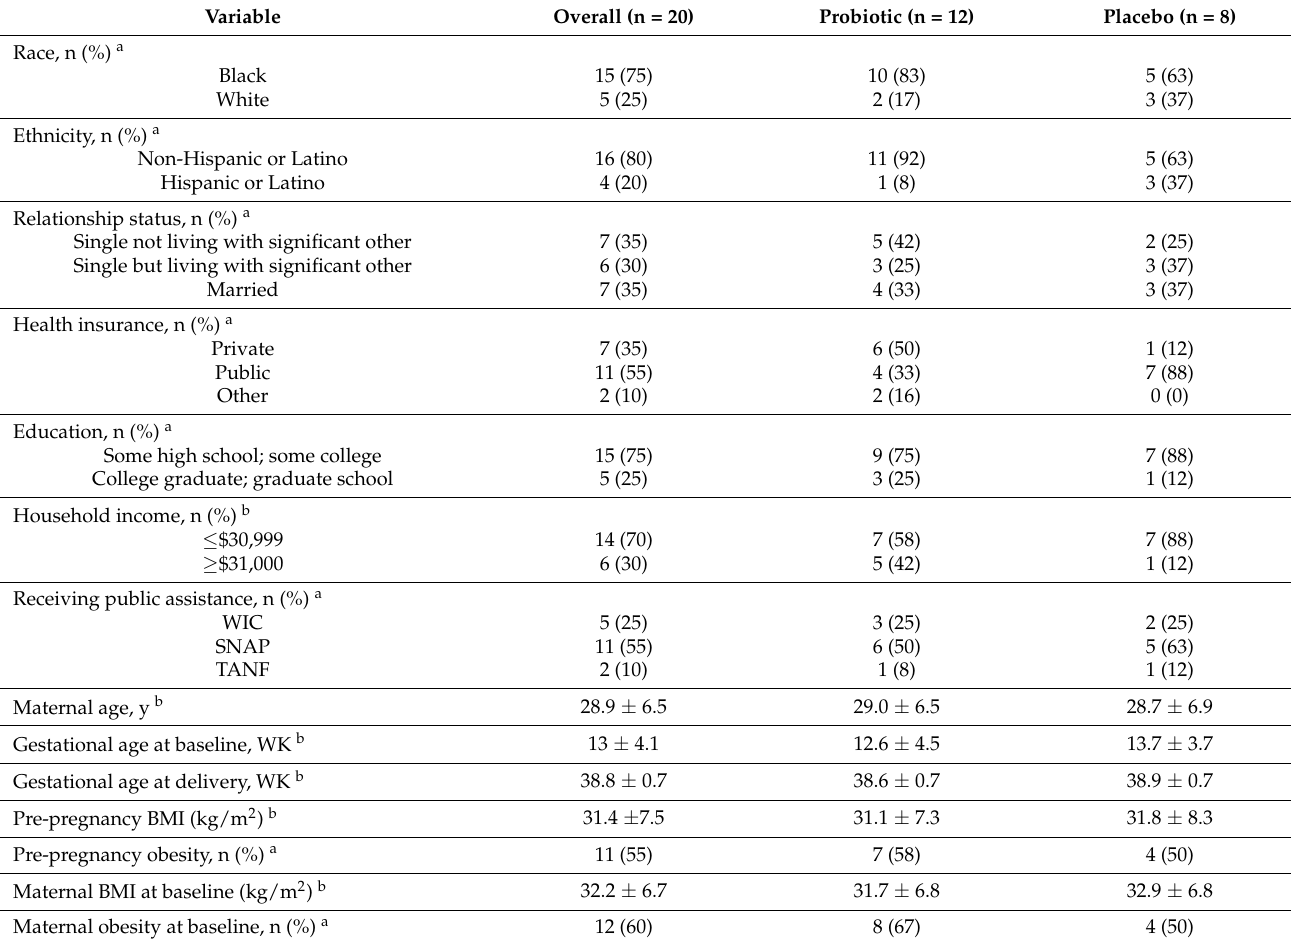
Table 2. Baseline demographic characteristics overall and by randomization